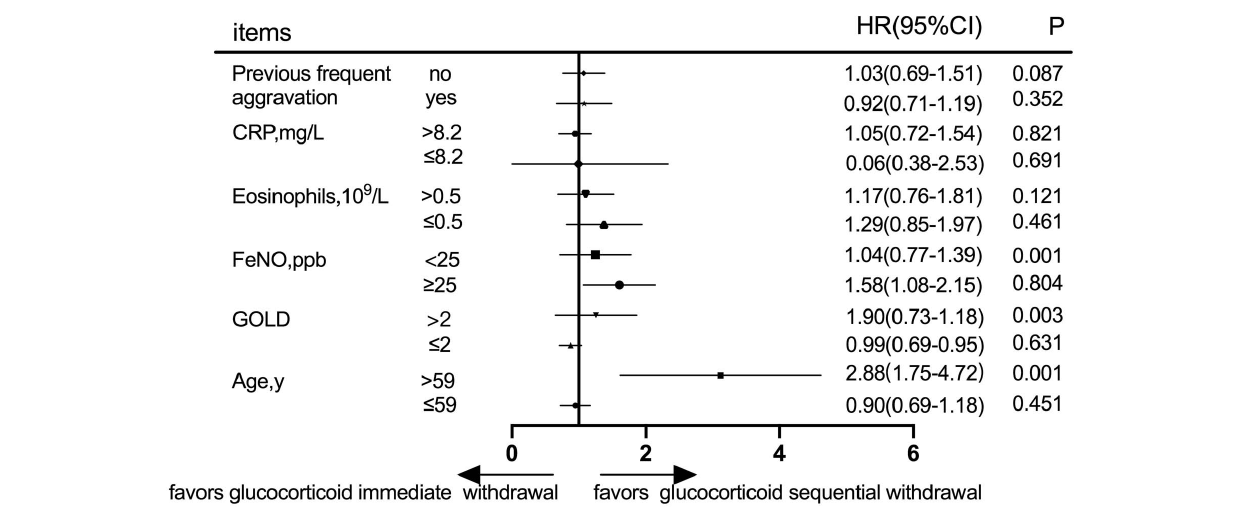
Frontiers in Molecular Biosciences |